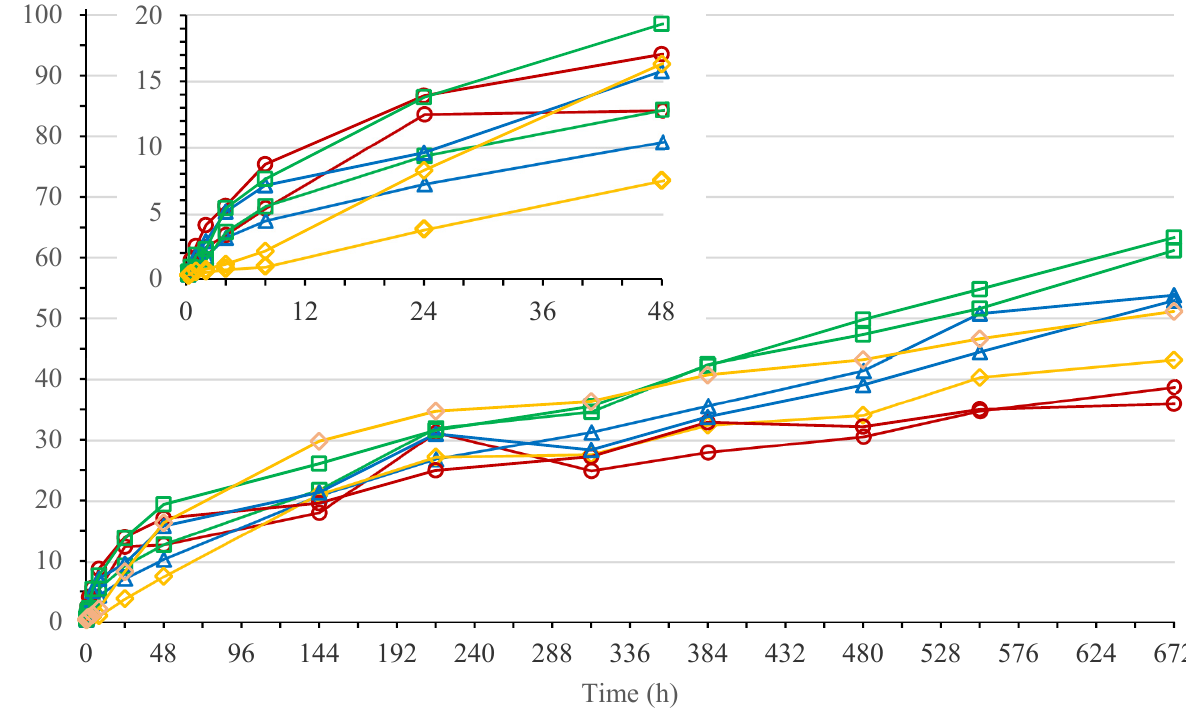
Figure 1. In vitro release of bedaquiline for in situ forming gel (ISG) formulations 1 to 4 (individual profiles for n = 2). Red circle: ISG formulation 1 (200 mg eq./g bedaquiline fumarate salt in PLGA5050A/NMP 20/80% ( w / w )); blue triangle: ISG formulation 2 (200 mg eq./g bedaquiline fumarate salt in PLGA7525A/NMP 20/80% ( w / w )); green square: ISG formulation 3 (200 mg eq./g bedaquiline fumarate salt in PLGA7525E/NMP 20/80% ( w / w )); orange diamond: ISG formulation 4 (200 mg eq./g bedaquiline fumarate salt in PDLLA/NMP 20/80% ( w / w )).